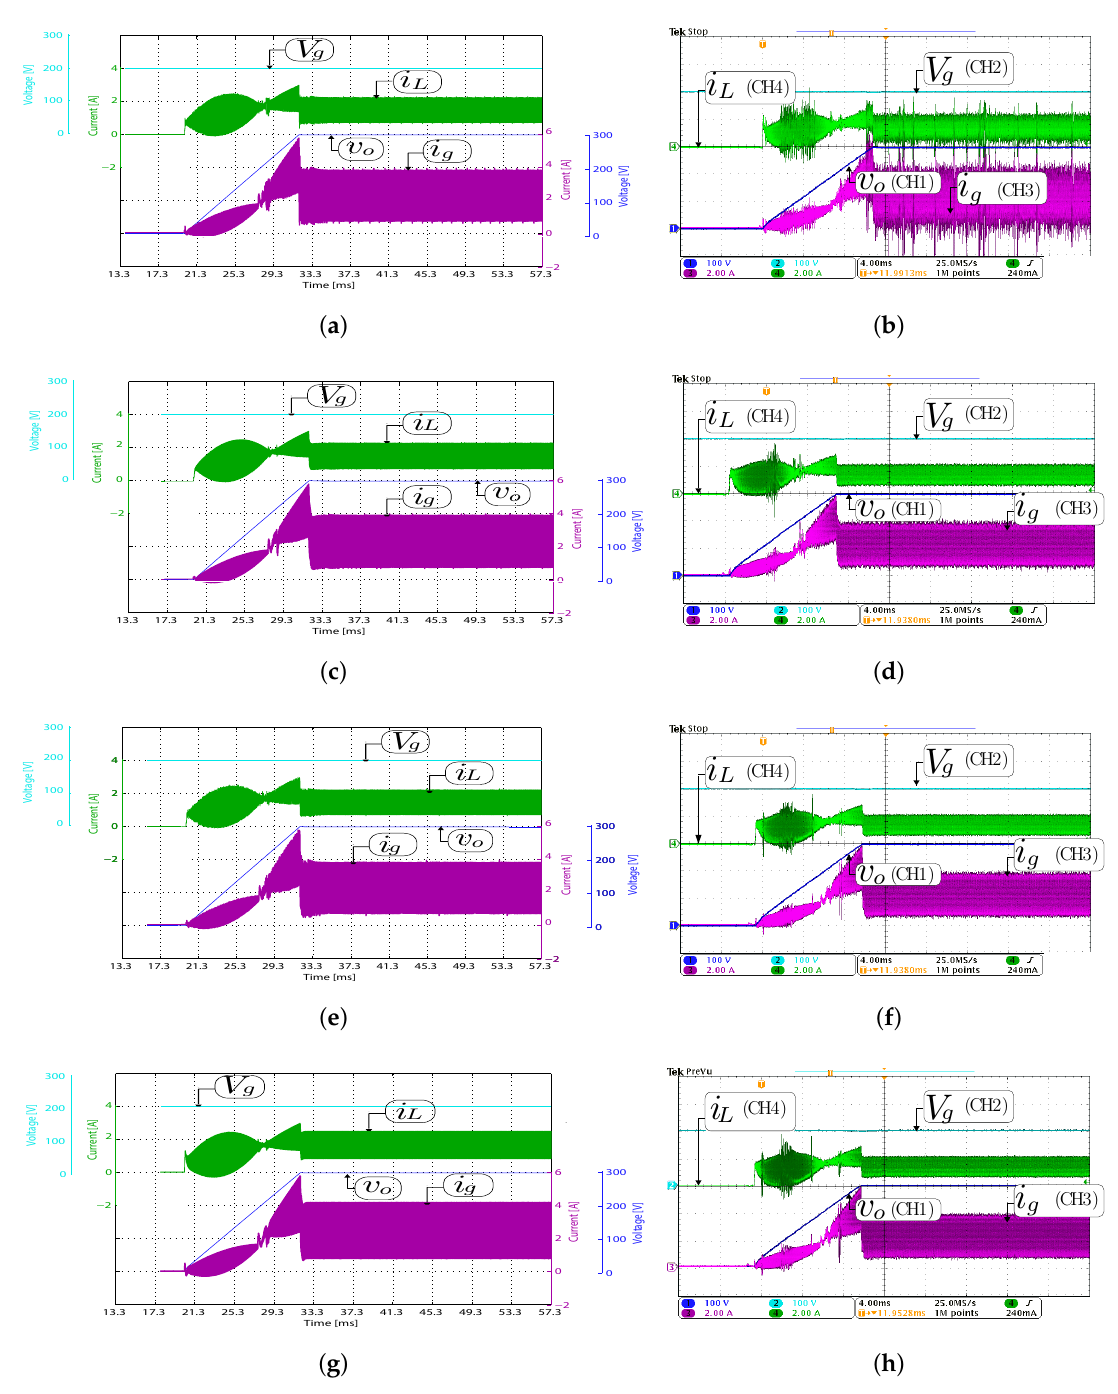
Figure 7. Simulated ( a , c , e , g ) and experimental ( b , d , f , h ) start-up waveforms: ( a , b ) Test 1, ( c , d ) Test 2, ( e , f ) Test 3, and ( g , h ) Test 4 ( V g = 200 V, v o = 300 V, and R o = 200 Ω ). CH1: v o (100 V/div). CH2: V g (100 V/div) CH3: i g (2 A/div), CH4: i L (2